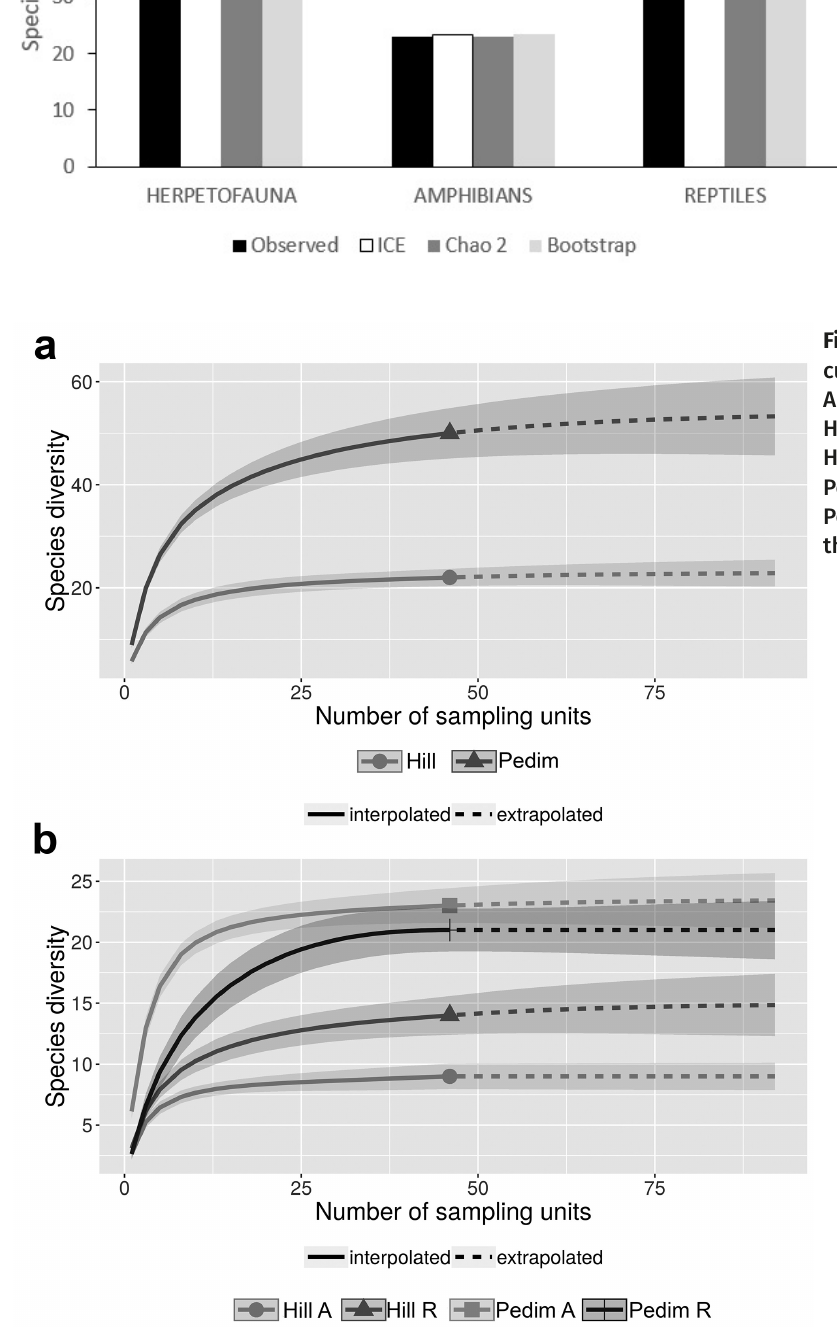
Figure 2. Non-parametric estimations of species richness for Herpetofauna, Amphibians and Reptiles of Paraje Tres Cerros, Corrientes, Argentina.